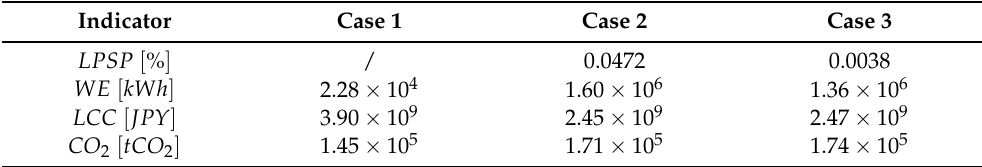
Table 5. Comparison of the three cases.